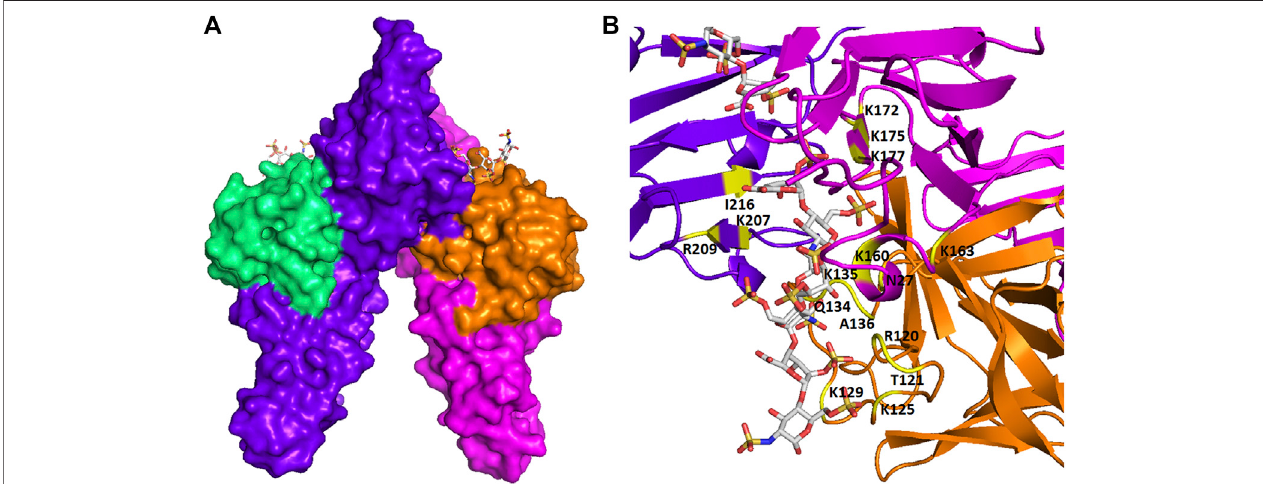
FIGURE2| ThespatialstructureofanFGF-FGFR-heparincomplex. (A) Thesurfaceview. (B) Theviewofribbonstructure.Theheparinfragments( Δ UA-GlcNS6S- IdoA2S-GlcNS6S-IdoA2S-GlcNS6S)thatmakecontactstotwoFGF2s(showningreenandorange)andtwoFGFR1s(showninpurpleandred)arerepresentedasballs and sticks. The amino acid residues that participate in the interaction are indicated. The fi gure was prepared by using PDB code 1FQ9, which was originally reported in the reference Schlessinger et al. (2000).